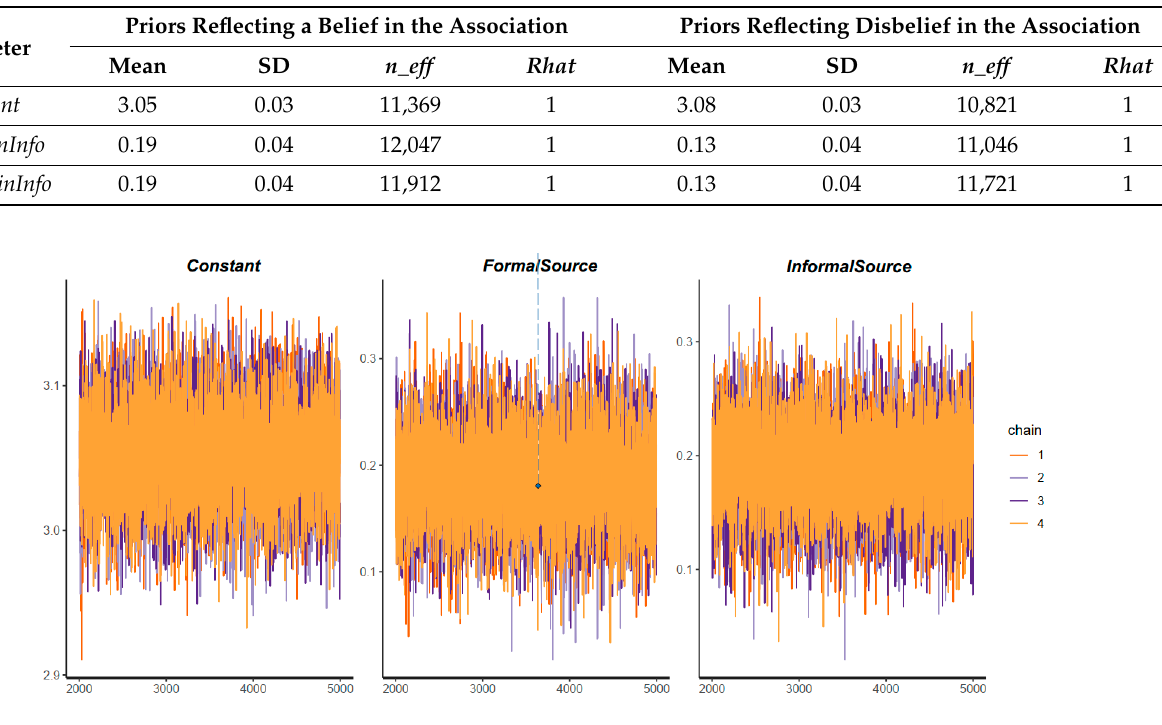
Table 4. Model 3’s simulated posterior coefficients.